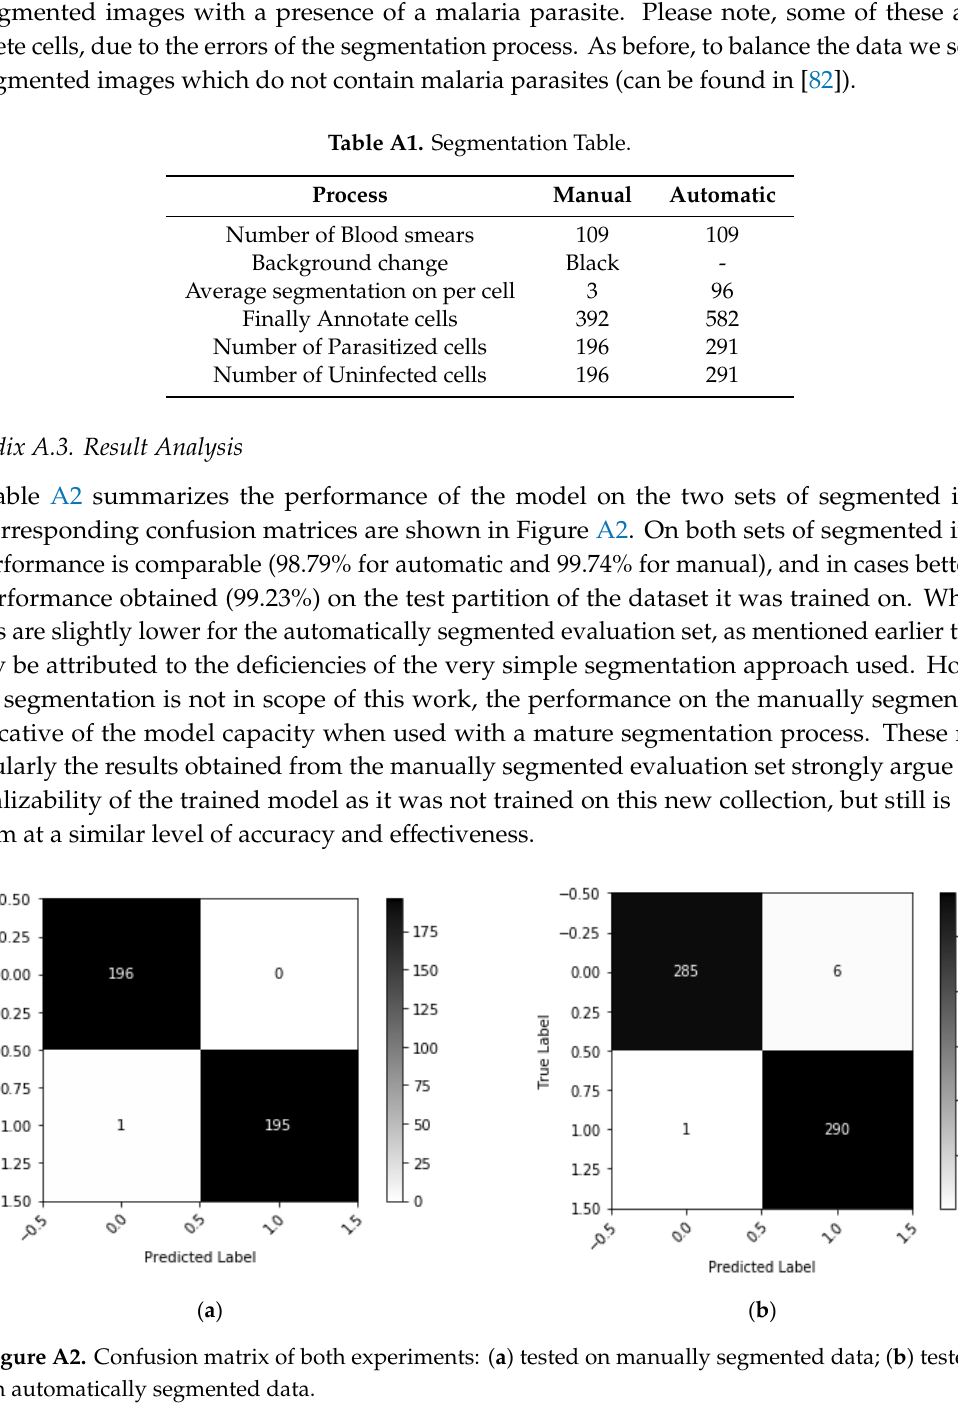
Table A1. Segmentation Table.